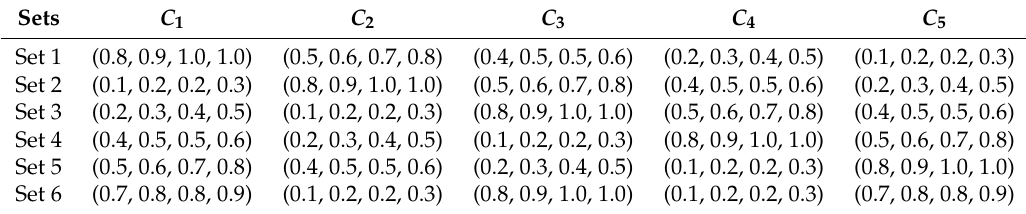
Table 15. The generated importance weights of the